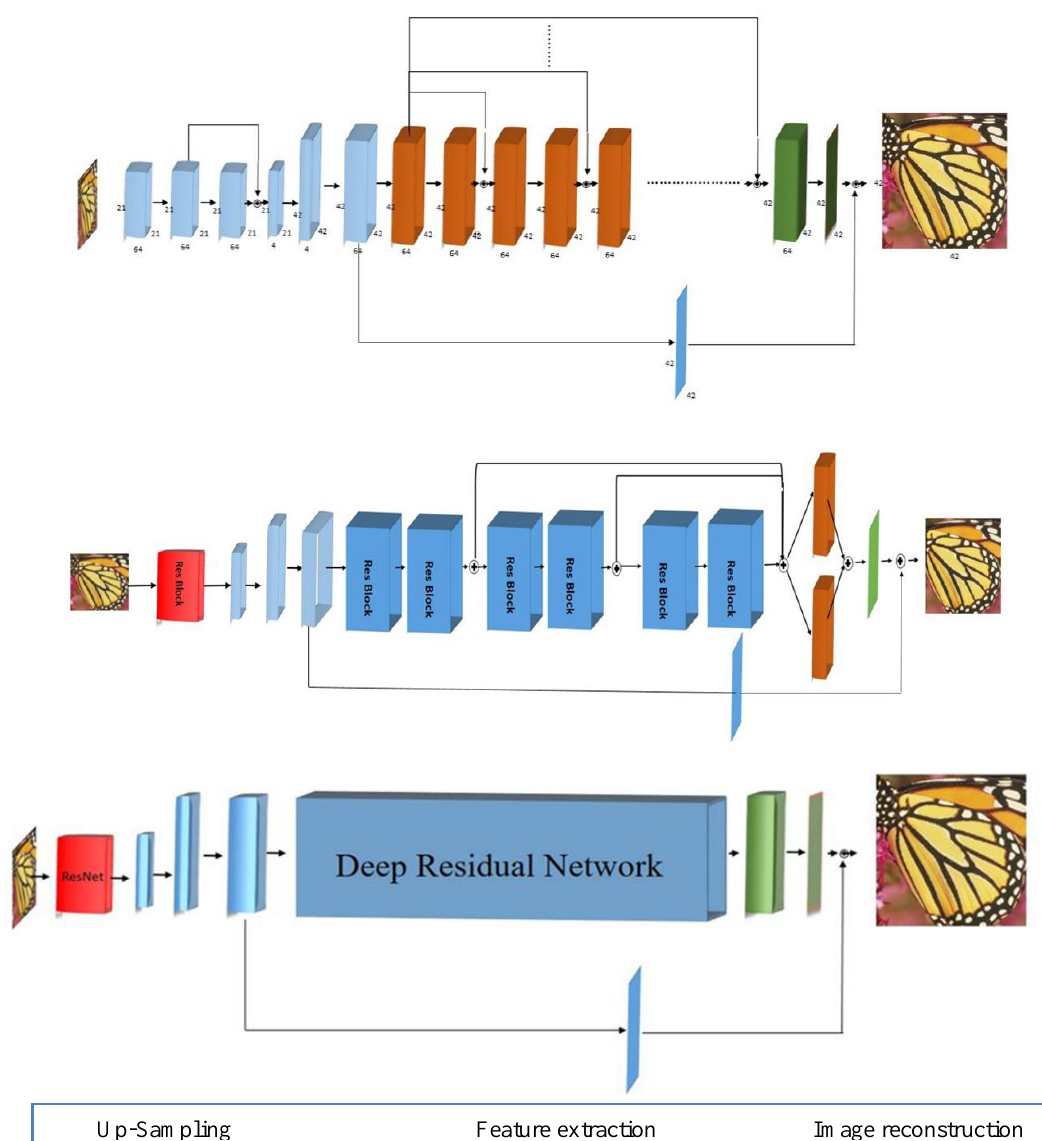
Figure 2. Architecture of the proposed model. First row: SCRSR, Second row: RBSR, Third row: